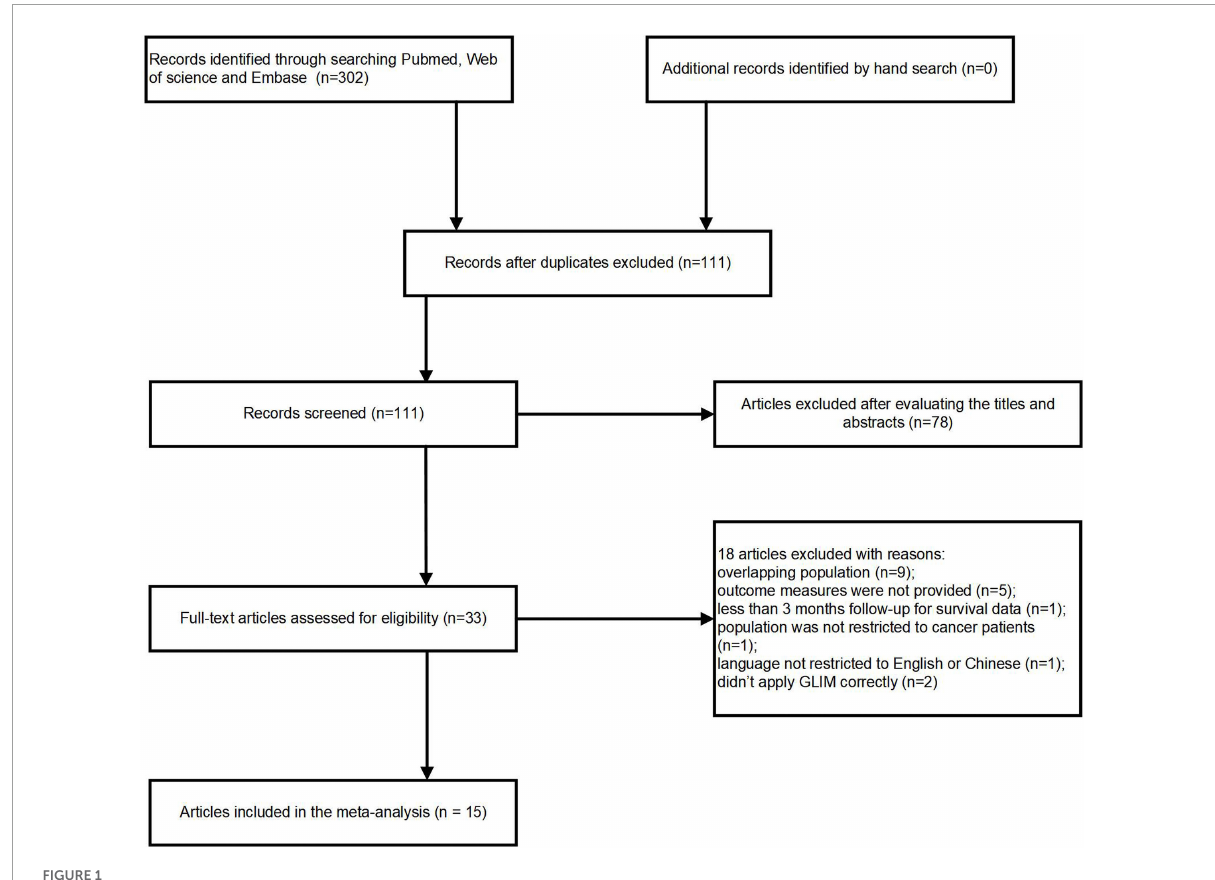
FIGURE1 Flow chart depicting the study inclusion and exclusion